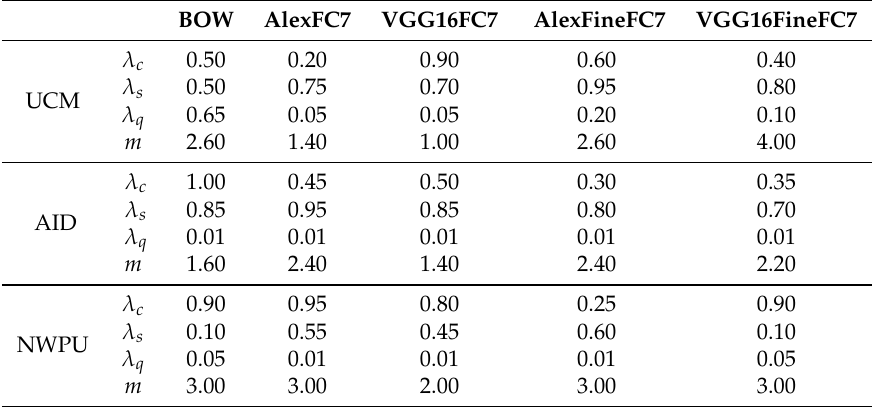
Table 5. Optimal parameters for different visual features and different image archives.